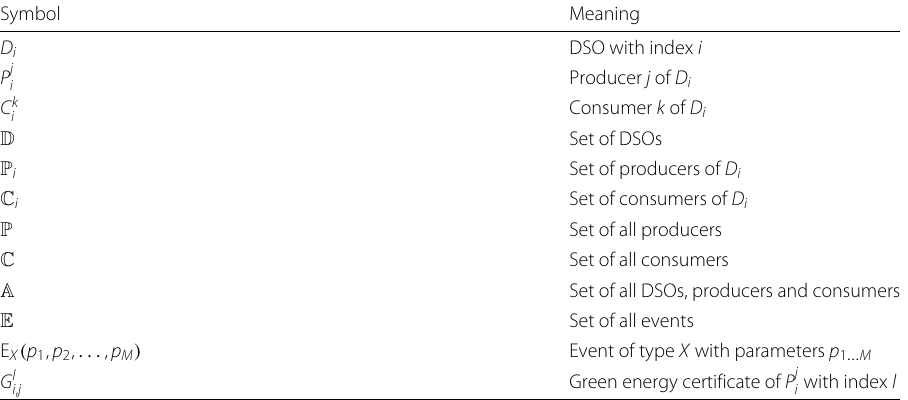
Table 2 Notation used in this